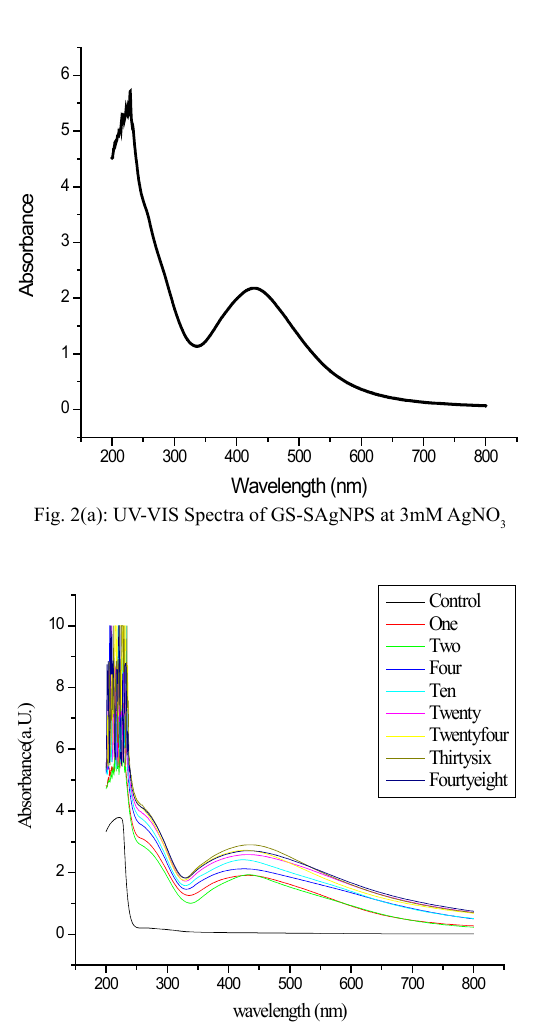
Fig. 2(b): UV-VIS Spectra of GS-RAgNPS at 3mM AgNO 3